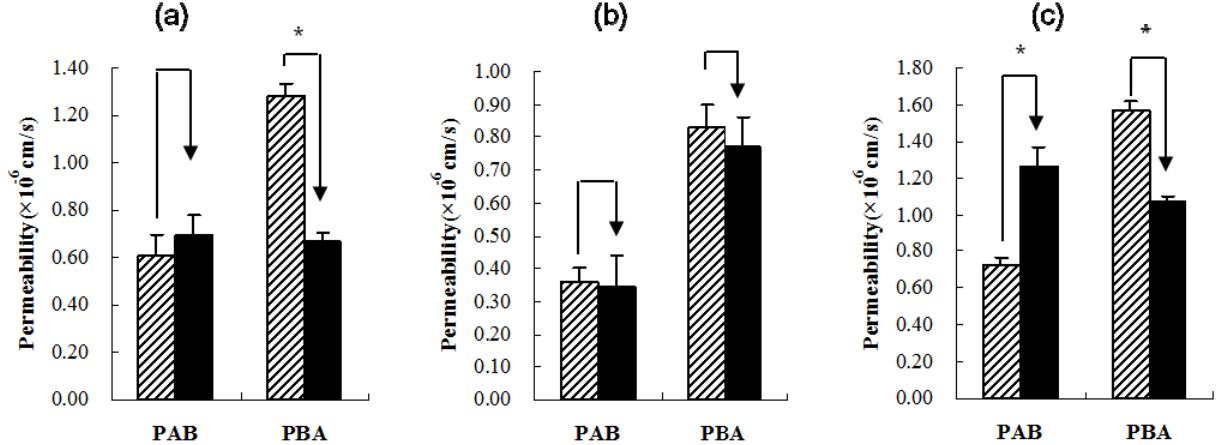
Figure 1. Effects of verapamil on permeability of paeoniflorin, glycyrrhizic acid, and liquiritin. ( a ): Paeoniflorin, ( b ): Glycyrrhizic acid, ( c ): Liquiritin. In the each column figure, slash column refers to absent of verapamil; black column refers to presence of verapamil. * p < 0.05, presence of verapamil vs. absence of verapamil.